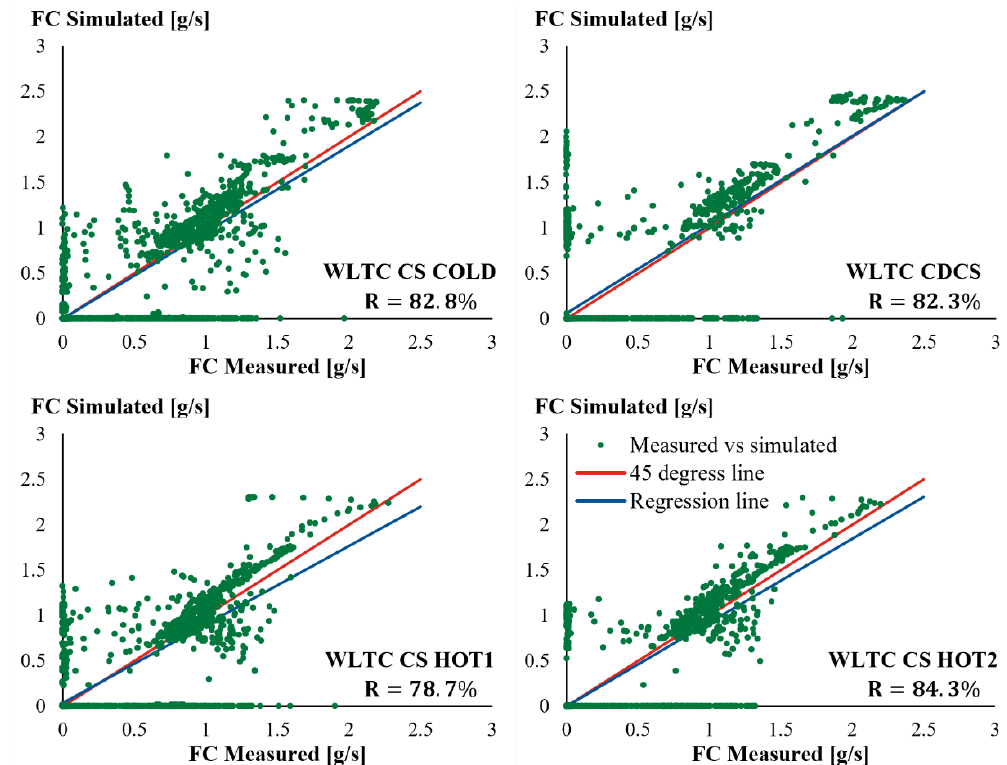
Figure 5. FC measurement vs. simulation — examples .